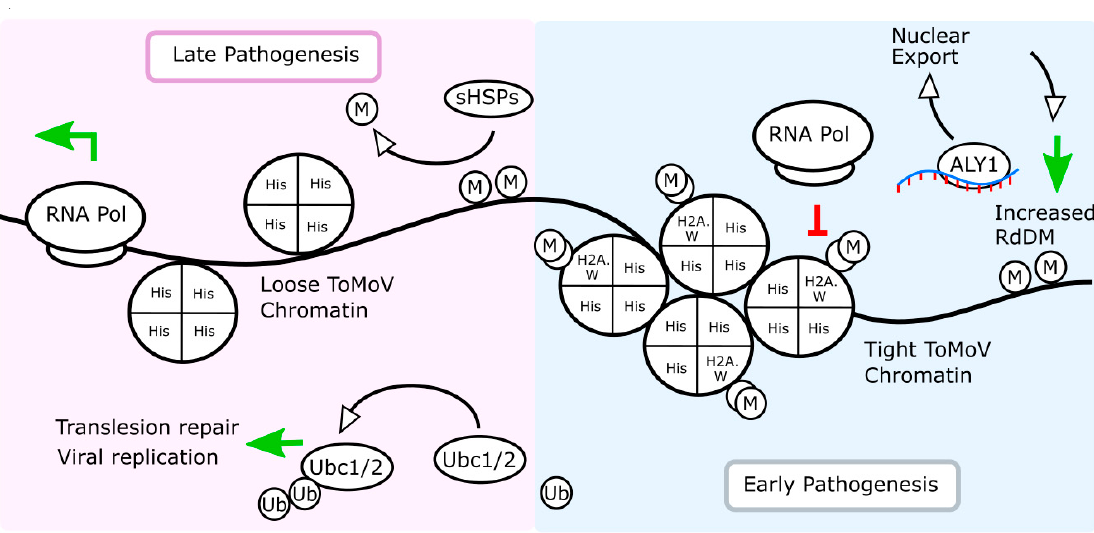
Figure 5. Interpretive model of ToMoV-specific protein changes identified in this study in transitioning from local early to late pathogenesis in systemic leaves. The increased abundance of ALY1-like protein (Solyc11g073280) early in pathogenesis at 3 dpf is consistent with an increased RNA-dependent DNA methylation (RdDM, green arrow, right) plant strategy to facilitate transcriptional gene silencing (TGS). Significantly less ALY1-like protein was observed in + WF V at 10 dpf. Similarly, the likely- histone variants demethylated H2A and H2A.W (Solyc01g099410 and Solyc11g073250) which have been shown to associate with condensed and transcriptionally inactive heterochromatin (red “T”, right) became less abundant at 10 dpf in + WF V leaves, suggesting a potentially relaxed heterochromatin state that may facilitate increased ToMoV gene expression. Other methylation states not shown in this model can also a ff ect chromatin structure. An increase in UBC1 and 2 (Solyc01g007860 and Solyc10g083120), which have been associated with translesion repair, as well as the IDM-like sHSPs (Solyc01g098810 and Solyc04g082720) previously shown to decreased DNA methylation and relieve TGS (green arrows, left), were both more abundant late in pathogenesis at 10 dpf in response to ToMoV. His, non-specific histone; M, methyl group; RNA Pol, RNA-dependent DNA polymerase; sHSPs, IDM-like small heat shock proteins; Ubc1 / 2-like, ubiquitin conjugating protein; ALY1, Ally of AML-1 and LEF-1-like protein; ToMoV, tomato mottle virus; RdDM, RNA-dependent DNA methylation.